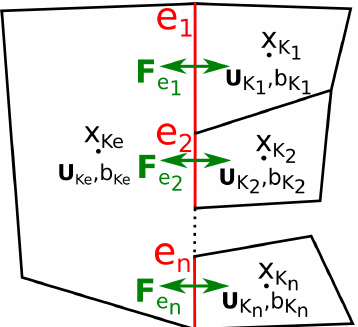
Figure 3. Internal multi-D domain interface, general case. At each cell center x , the state variables U = (h,hu,hv) T and the bathymetry b are defined. The total numerical flux is conserved: (cid:16) (cid:17) m e , U n , n e F e = (cid:80) F e U n Ke K, i i i i ,K i = 1 ... n